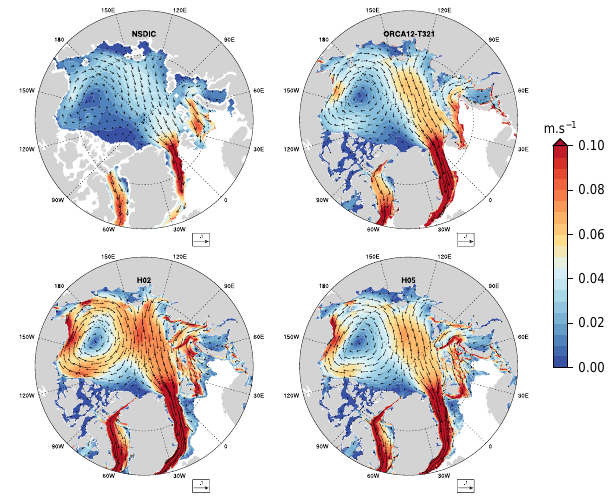
Figure 18. Average ice velocity (in ms − 1 ) for March 2003–2008 from NSIDC, the ORCA12 T321 run from Mercator Océan and CREG12 hindcasts H02 and H05.